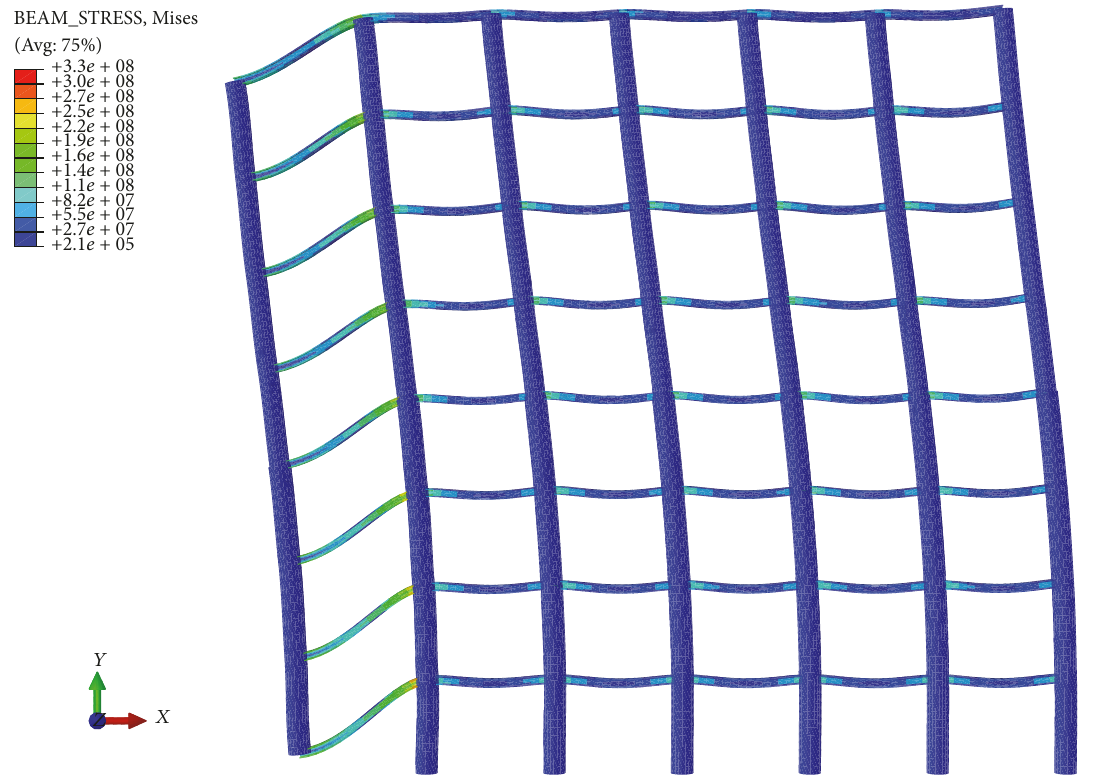
Figure 15: Deformation of the hybrid frame after the failure of the bottom corner column.